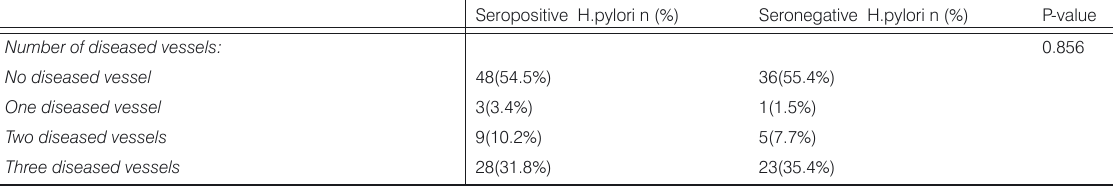
Sandard deviation, SD; H.pylori, Helicobacter. pylori; Body mass index, BMI; triglyceride, TG; high-density lipoprotein, HDL, low-density lipoprotein cholesterol, LDL Table 6. The prevalence of seropositive H.pylori infection as regards the diseased coronary